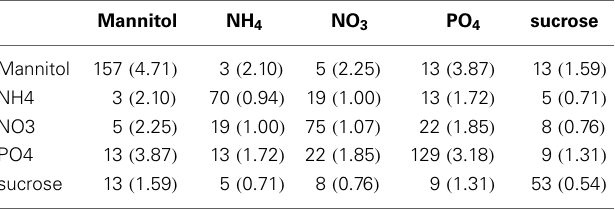
Table 2 | Number of phosphoproteins found in common between two treatments.